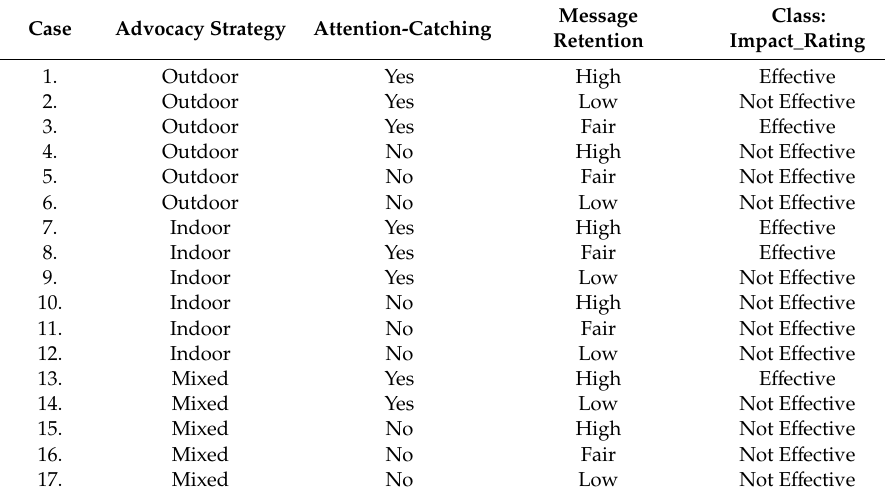
Table 2. A sample of poverty-related advocacy data.